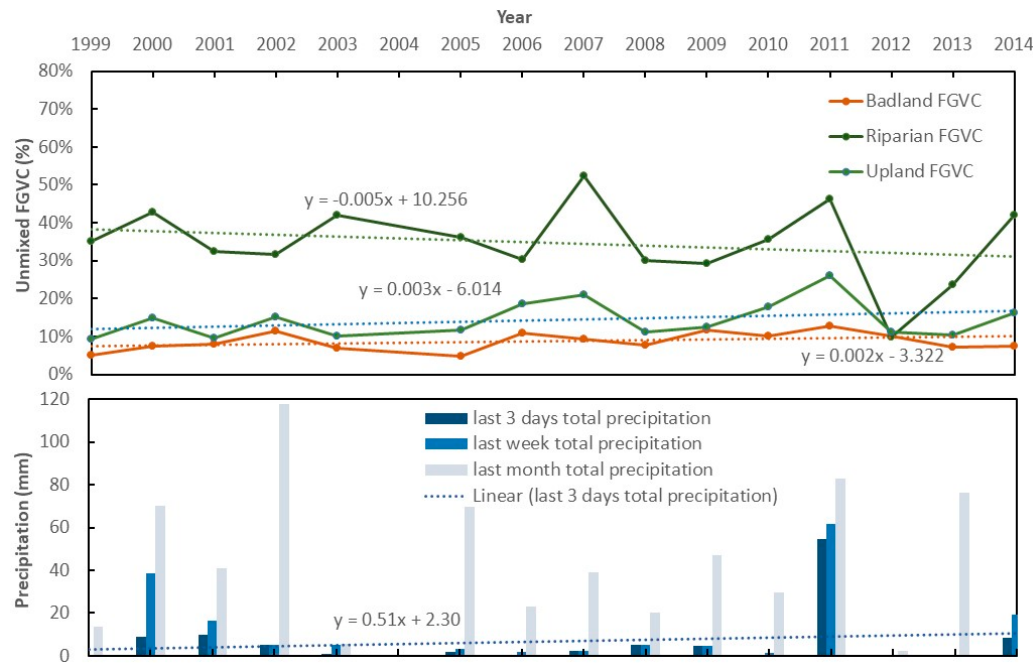
Figure 12. The unmixed FGVC extracted from typical badlands, typical riparian zone, and typical uplands from 1999 to 2014, their linear regression trend lines ( a ), and the total precipitation from the last three days to the last month before the images were taken and the last three-day total precipitation linear regression trend line ( b ). Table 2. Correlations between the unmixed FGVC and total precipitation from the last 3 days to the last month before the images were taken.